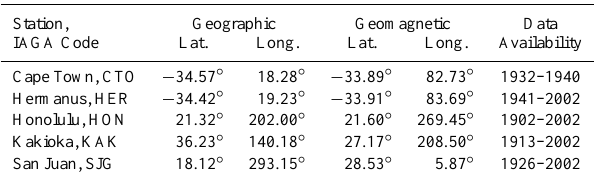
Table 1. Geographical and geomagnetic coordinates, according to IGRF 2000 model (IGRF, 2000) and data coverages of the D st mag- netic stations. Station, Geographic Geomagnetic Data IAGA Code Lat. Long. Lat.